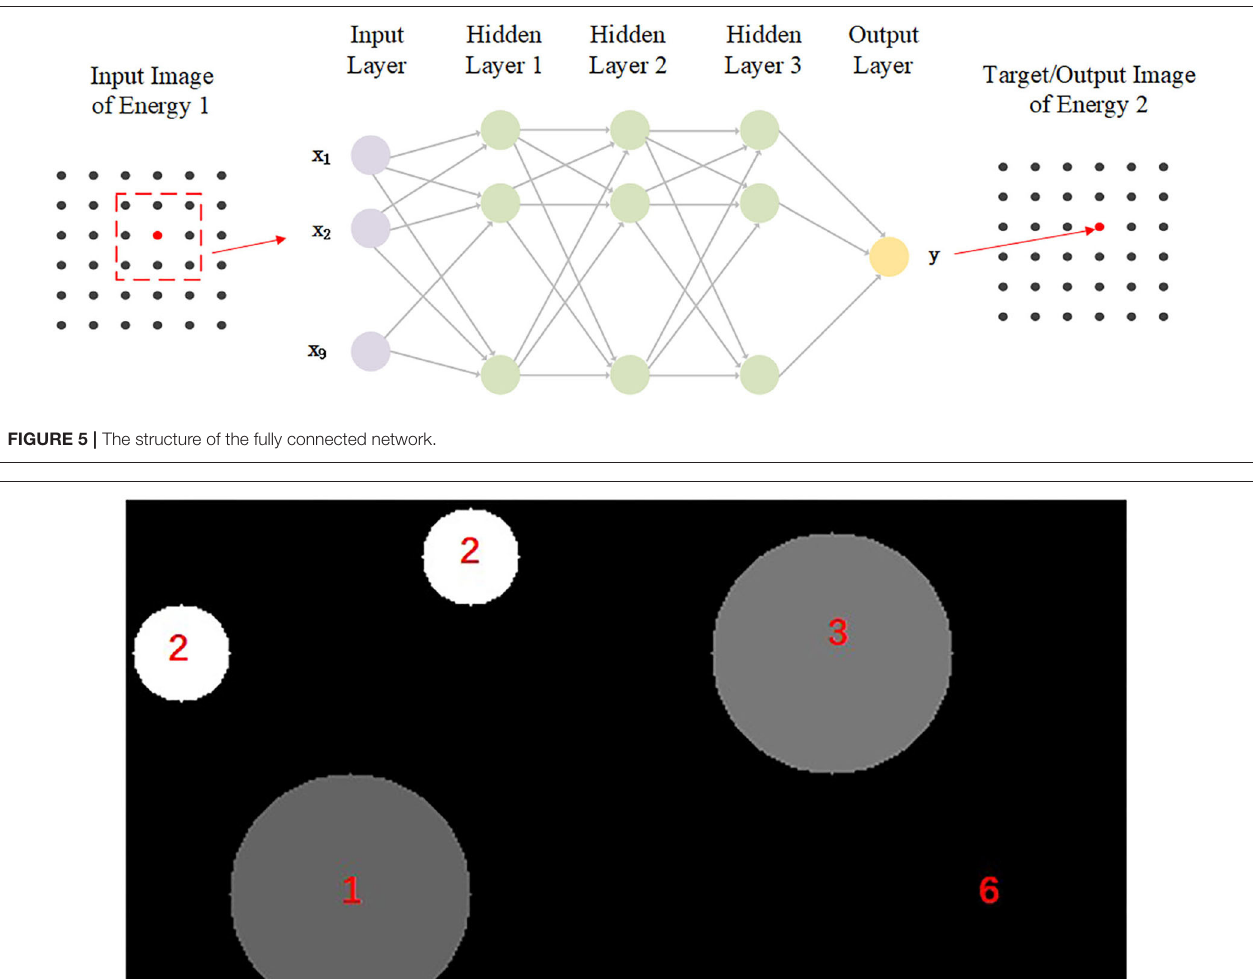
Frontiers in Physics |